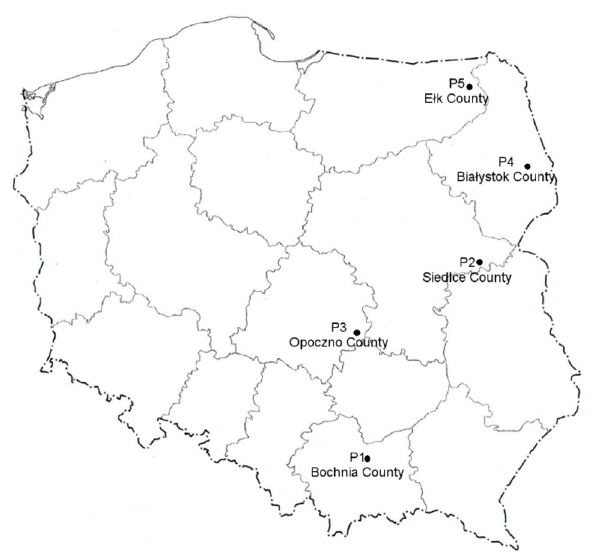
Figure 4. Polish map showing the location of sampling propolis from five different Polish counties.